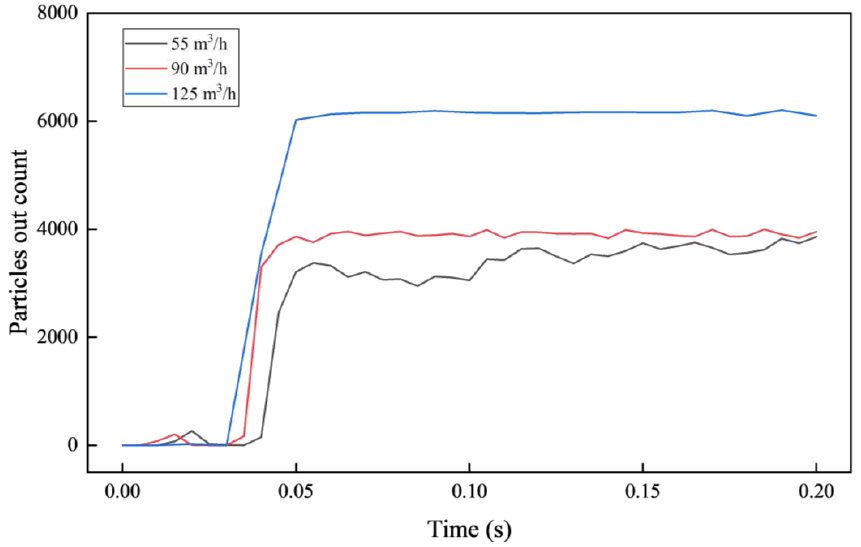
Figure 20. Spill velocity of 1.4 mm LCMs at different displacements.